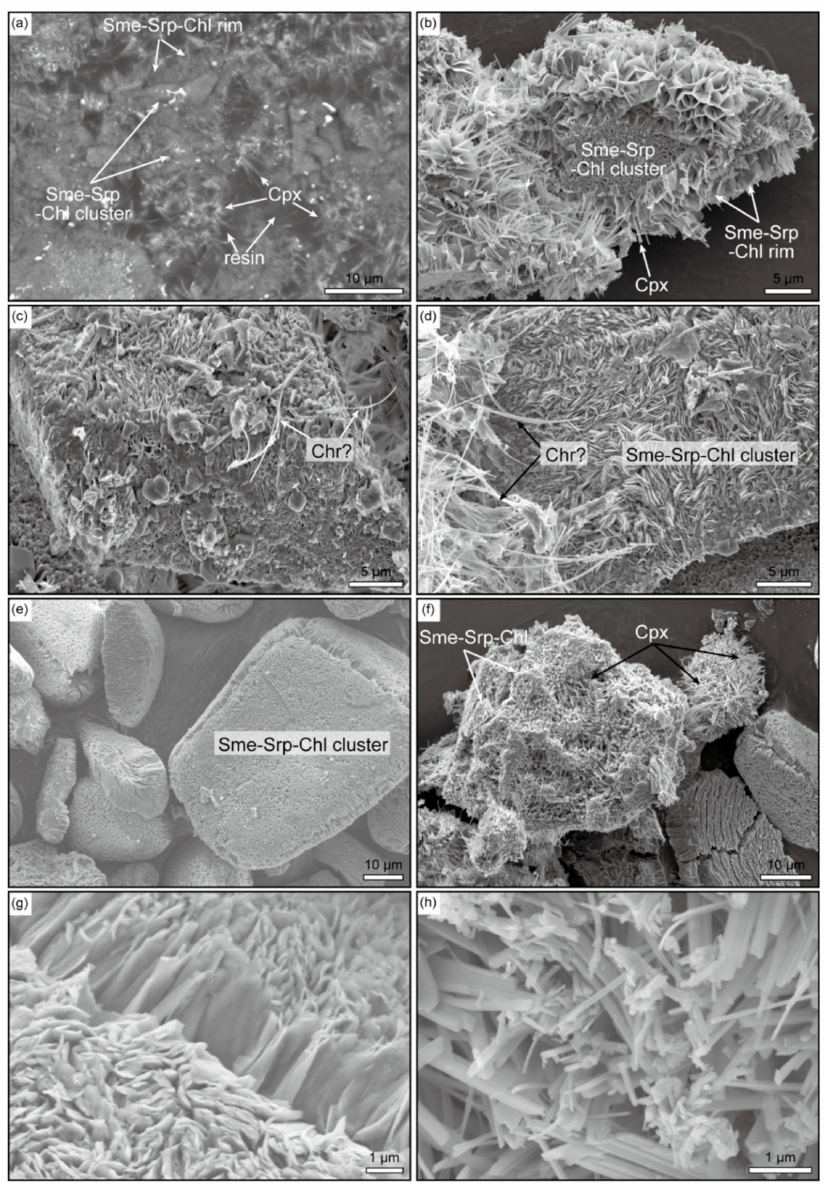
Figure 7. Representative SEM images of alteration products after experiment N350 (350 ◦ C, 2520 h). ( a ) A polished sample mounted on epoxy resin showing clusters of phyllosilicates (smectite, ser- pentine, and chlorite) in the core with overgrowth rims of phyllosilicates and needle-like crystals of clinopyroxene. The dark portion of the panel is epoxy resin. ( b – d ) SEM images of crushed samples. ( b ) Cluster of phyllosilicates. The core of the cluster comprises plates/flakes that develop an edge-to- face pattern and/or a rosette-like pattern, whereas the rim shows honeycomb texture with 2–3 µ m pores. Needle-shaped clinopyroxene occurs with overgrowth rims of phyllosilicates. ( c , d ) Cluster of phyllosilicates with an unidentified polygonal mineral and a fibrous mineral that is presumed to be chrysotile. ( e , f ) Unsuspended fraction showing rounded clusters comprising phyllosilicates ( e ) and irregular-shaped clusters comprising clinopyroxene and phyllosilicates ( f ). ( g ) Enlarged view of a phyllosilicate cluster. Plates/flakes develop an edge-to-face pattern. ( h ) Enlarged view of needle-shaped clinopyroxene. Abbreviations are the same as in Table